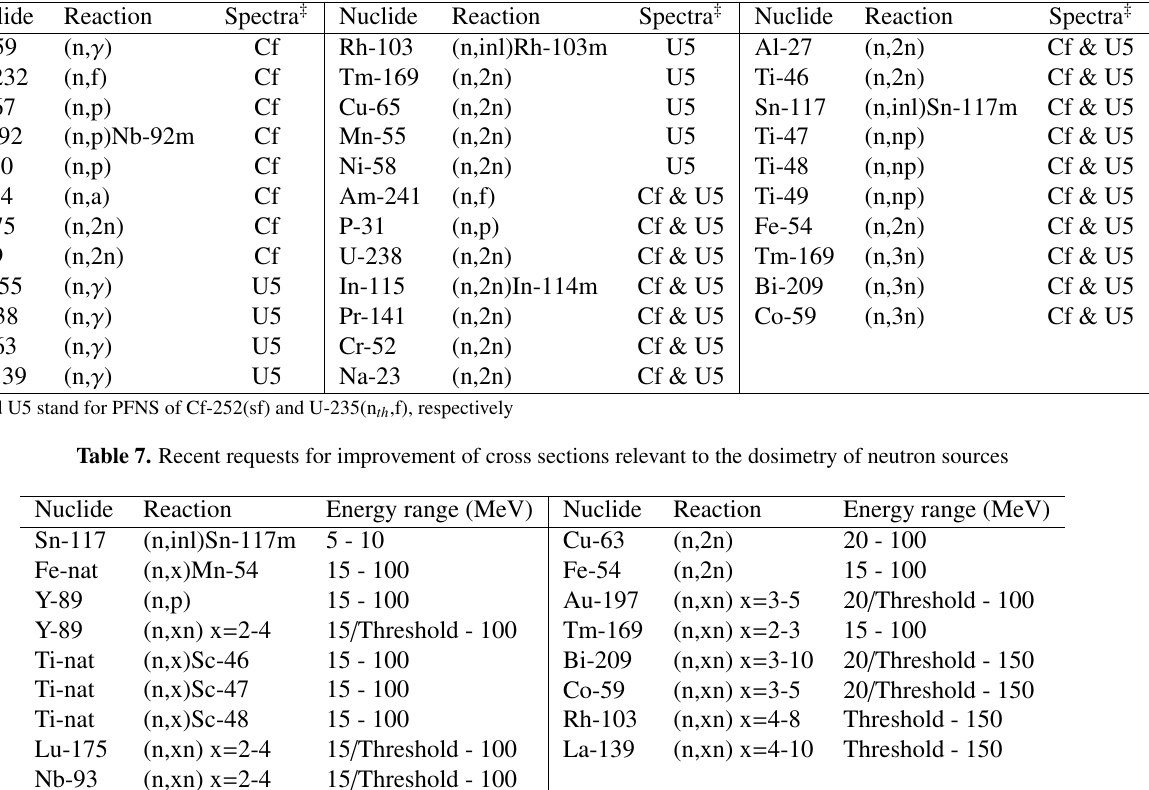
Table 6. Recent requests for spectrum-averaged cross sections relevant for the improvement and validation of IRDFF